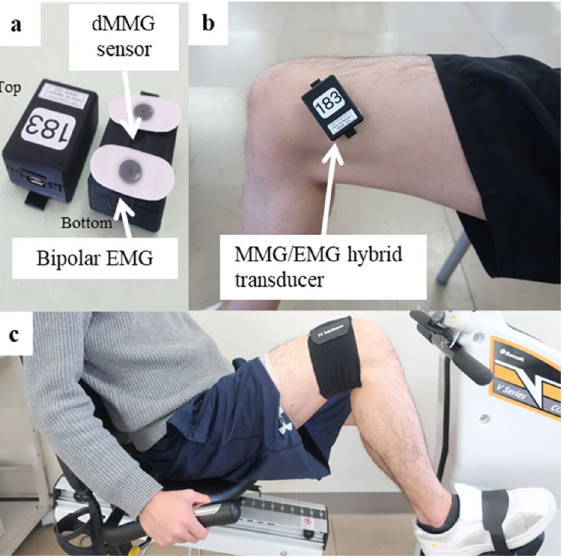
Figure 1. Example of measuring EMG and dMMG. ( a ) MMG/EMG hybrid transducer. ( b ) Attachment the MMG/EMG hybrid transducer to the skin surface of the vastus medialis. ( c ) Subject sits on the recumbent bicycle with both toes fixed to the pedals and both hands gripping the